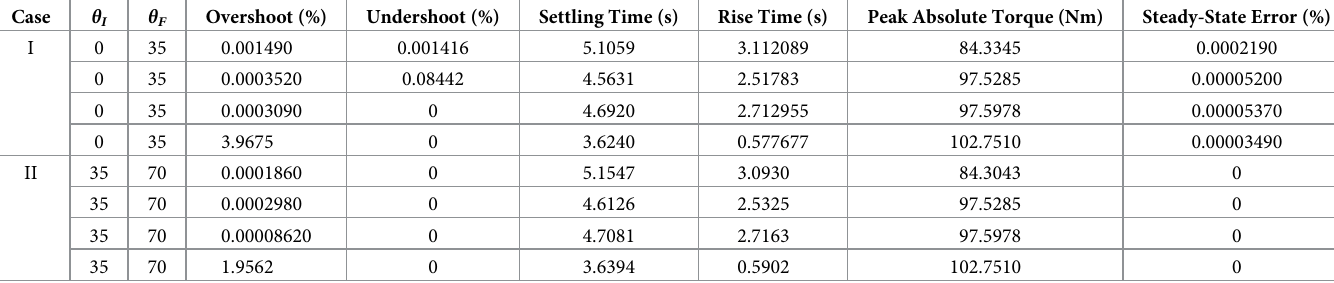
Table 5. Summary of results for SFG-MIMO PI.